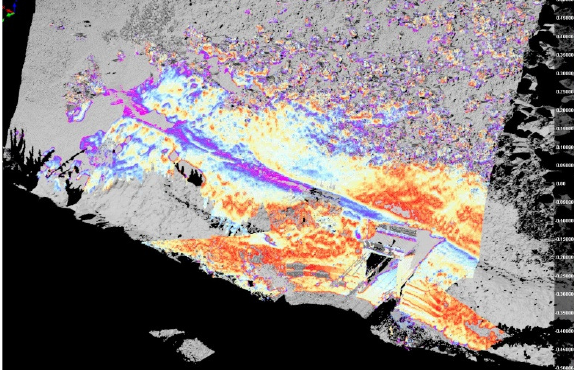
Figure 8. Comparison between two successive Comparison between two successive